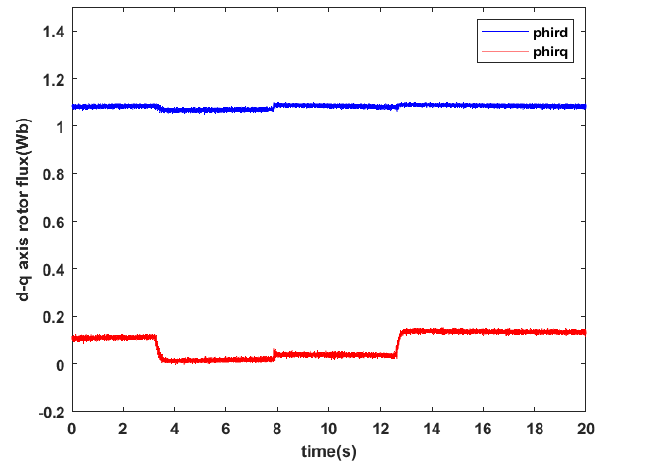
Figure 16. d-q axis rotor